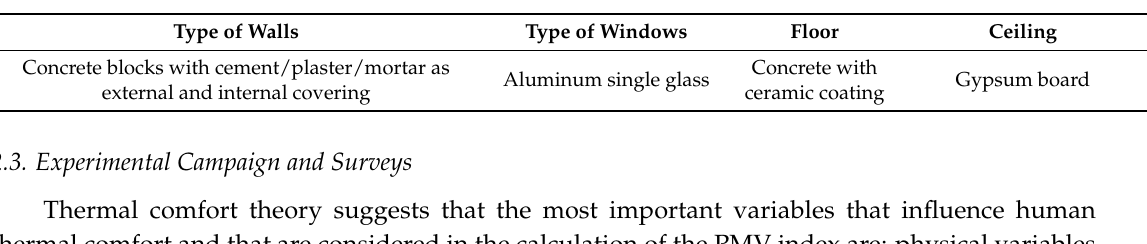
Table 1. Construction materials of the selected office.